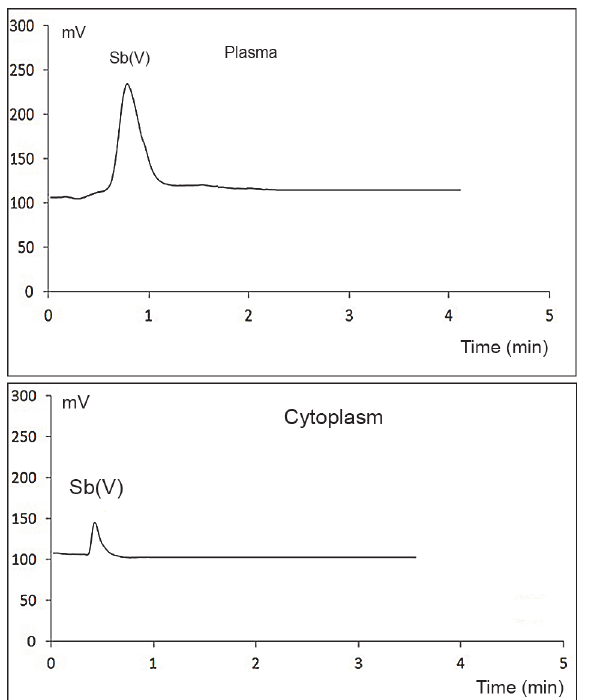
Figure 1. Speciation of Sb in the plasma (upper) and cytoplasm (lower) of human blood incubated with 200 ng mL − 1 Sb(V). * No trimethyl-Sb(V) was detected. * Incubation was performed in triplicate using collection tubes from single donor ’ s blood .